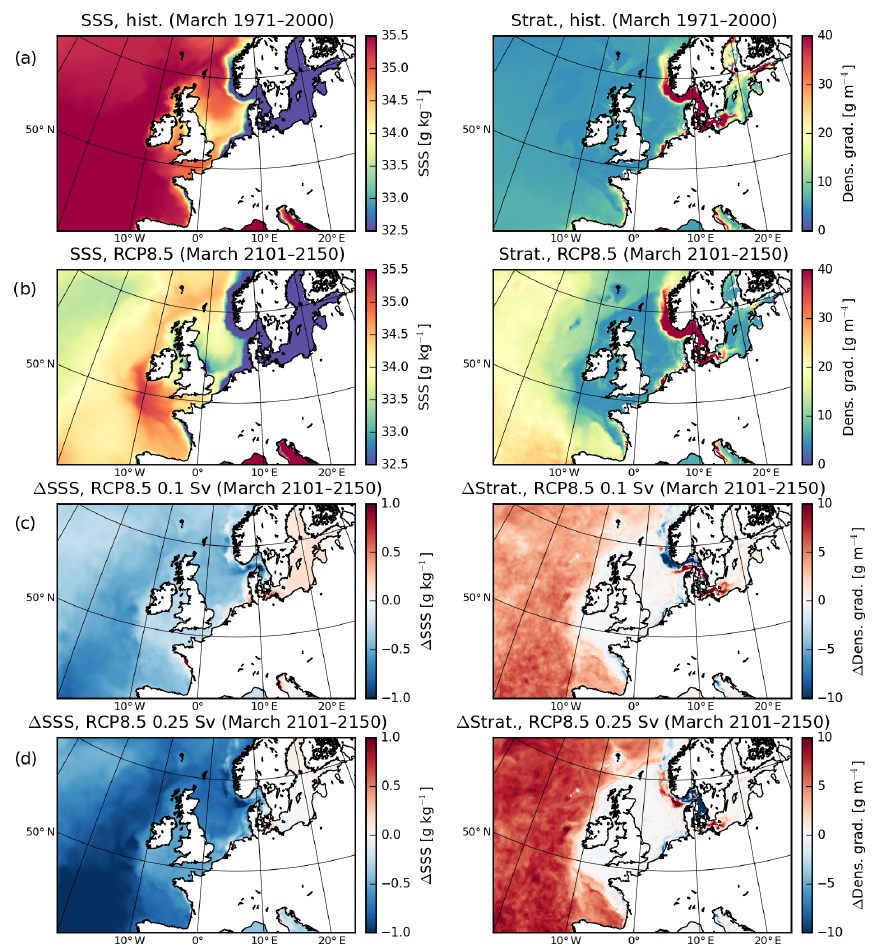
Figure A2. Sea surface salinity and strength of stratification at the end of winter (March) for historical (1971–2000, a ) and RCP8.5 (2101– 2150, E0, b ) conditions. Changes in RCP8.5 conditions (2101–2150) for experiments with 0.1Sv (E010, c ) and 0.25Sv (E025, d ) GIS meltwater discharge relative to the experiment without GIS meltwater discharge (E0, b